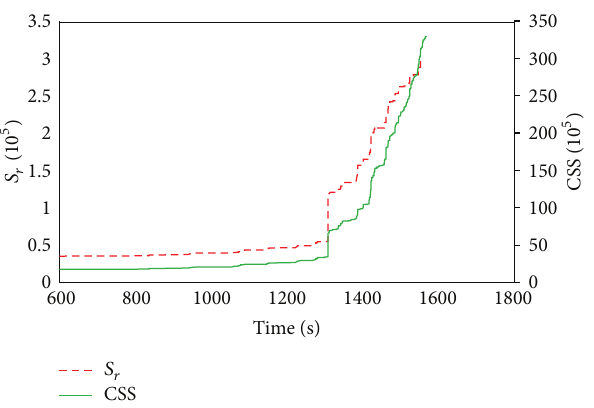
Figure 9: Severity index as a function of time for DC specimen. The plot of the cumulative signal is superimposed.